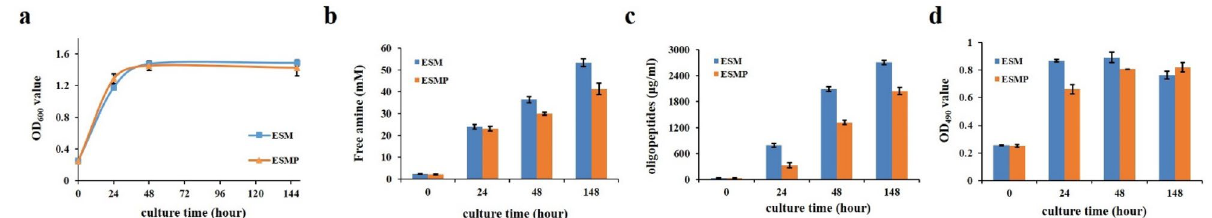
Figure 3. Microorganism-based ESM hydrolysis system. ( a ) The growth curves (OD 600) of M. taiwanensis WR-220 when using ESM or ESMP as sole nutrients for growth. ( b ) Concentration of free amines, ( c ) Concentration of oligopeptides and ( d ) Relative concentration of total sugar (OD 490) in ESM or ESMP hydrolysates during 148 h incubation with M. taiwanensis